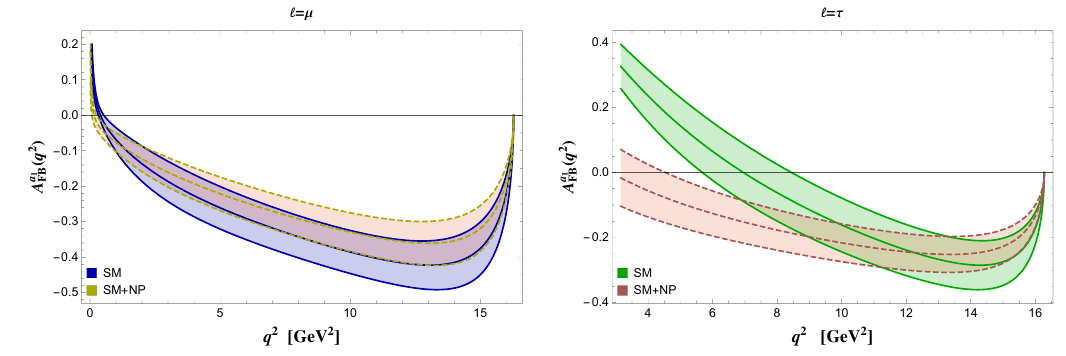
Figure 18. ¯ B → a 1 (cid:96) − ¯ ν (cid:96) : FB lepton asymmetries for (cid:96) = µ ( left ) and τ ( right